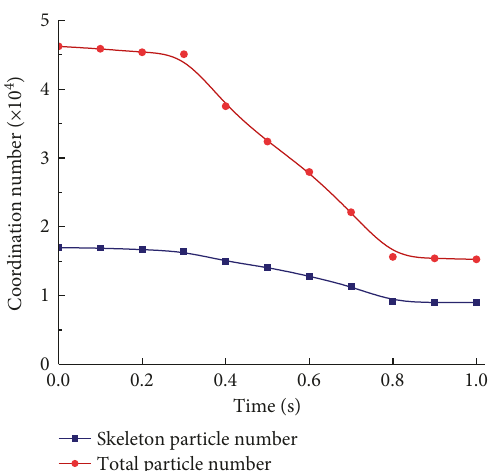
Figure 10: Curve of particle coordination number change.